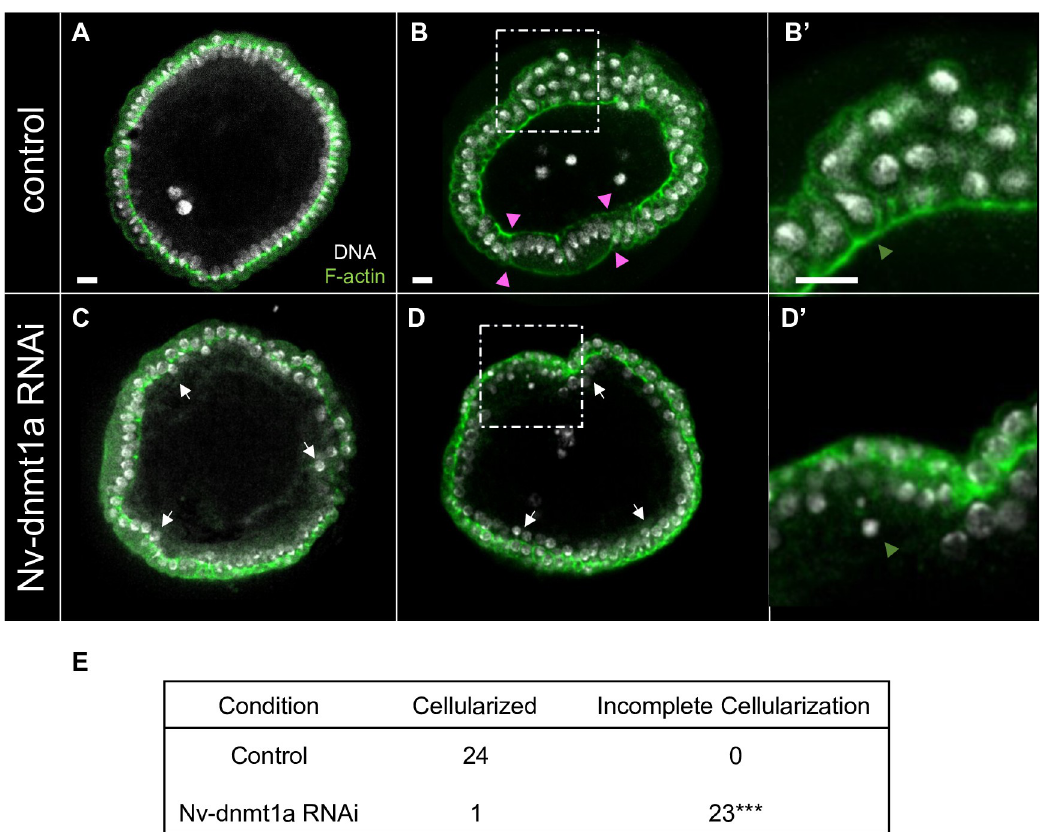
Fig 2. Transverse views of control and Nv-dnmt1a pRNAi embryos during cellularization and at the onset of gastrulation. Green, phalloidin (F-actin). white, DAPI (DNA). (A) Control embryo during mid cellularization. (B) Control embryo at the onset of gastrulation. Pink arrowheads demarcate the borders of the presumptive mesoderm. (B’) Zoomed in view of fully cellularized control embryo. Orange arrowhead points to the basal actin cable. (C) Nv-dnmt1a pRNAi embryo during mid-cellularization. White arrows point to examples of disordered nuclei. (D) Nv-dnmt1a pRNAi embryo at the onset of gastrulation. White arrows point to examples of non-cellularized, disordered nuclei. (D’) Zoomed in view of an Nv-dnmt1a pRNAi embryo that fails to fully cellularize. Orange arrowhead points to a non-cellularized nucleus (note the absence of the basal actin cable). (E) Table with n values of cellularized and non-cellularized control and Nv-dnmt1a pRNAi embryos. ��� = p-value < 0.0001 determined by Fisher’s Exact Test. All scale bars (white lines in A-A”‘) represent 10 μ